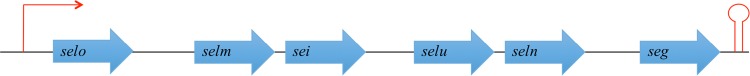
Arrangement of the enterotoxin gene cluster (egc) in S. aureus.The relative positions of the 6 SE and SEl genes, in blue, are located but not drawn precisely to scale. The putative promoter and transcriptional terminator are shown.